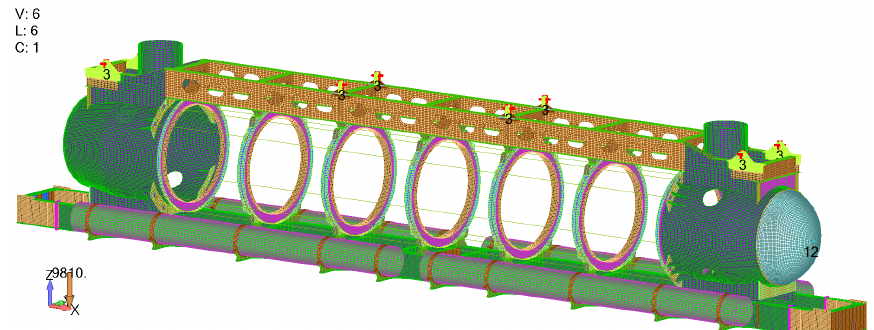
Figure 13. Boundary conditions and gravity loads for emergency lifting condition.